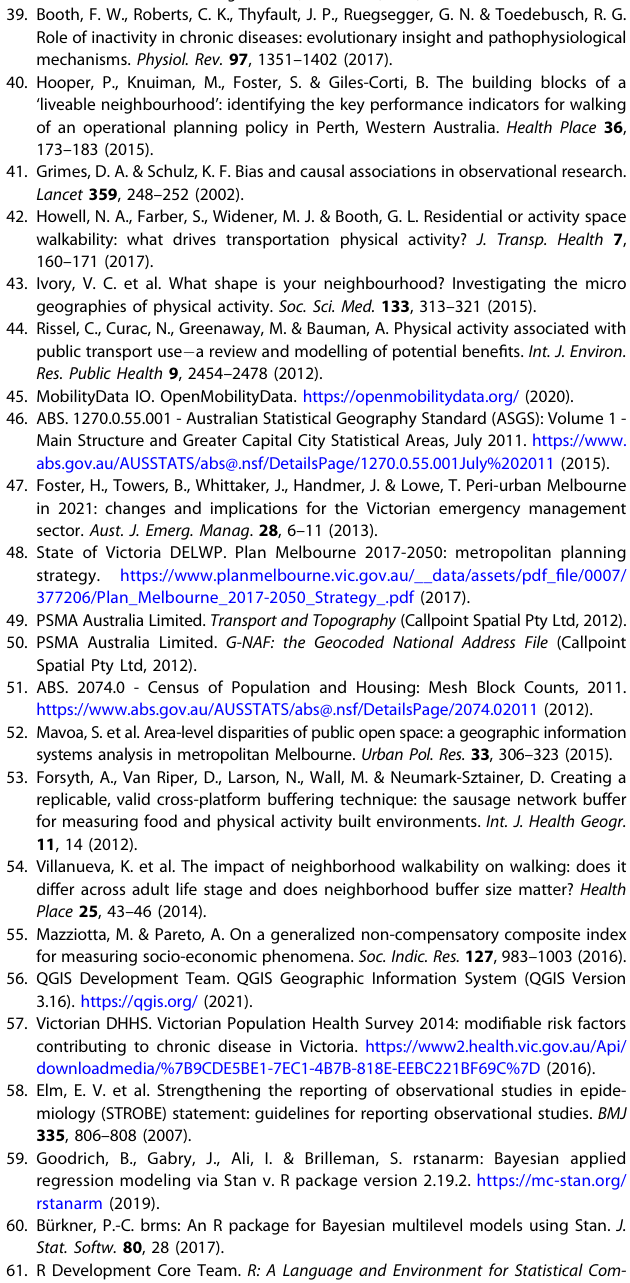
table healthier cities for sustainable development. https://apps.who.int/iris/ handle/10665/204715